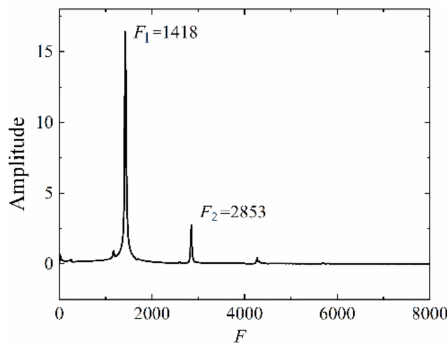
Figure 11. Distributions of surface oscillations when at Re s = − 1123, Re T = 7887. ( a ) Azimuthal distribution of surface concentration fluctuations. ( b ) Phase lag between the oscillations of concentration and velocity.